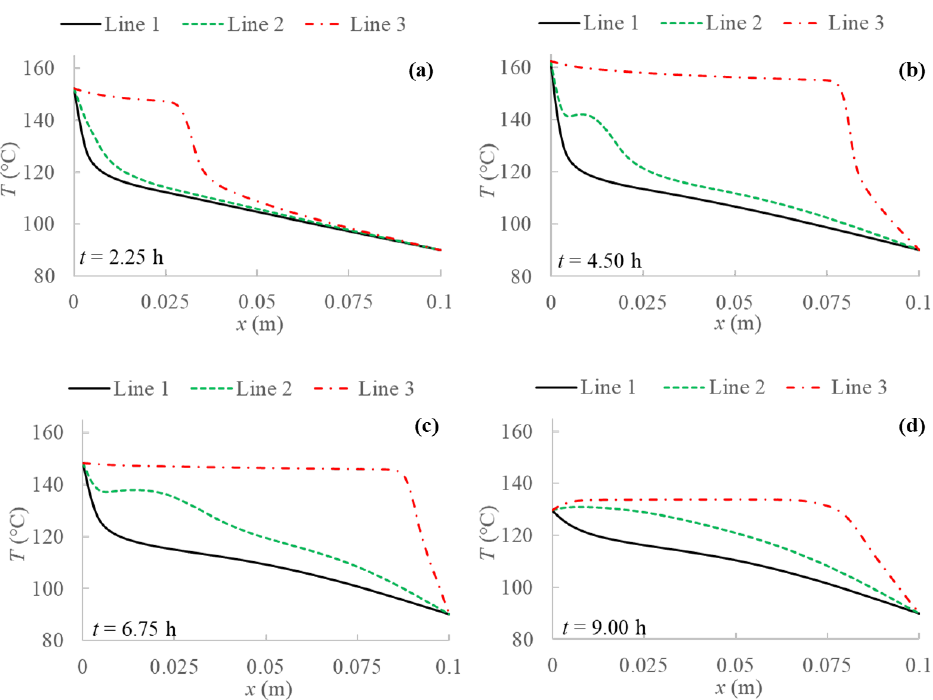
Figure 4. Scheme of the three different PCM transversal sections: Line 1 ( y = 0 m); Line 2 ( y = 0.05 m); Line 3 ( y = 0.1 m).